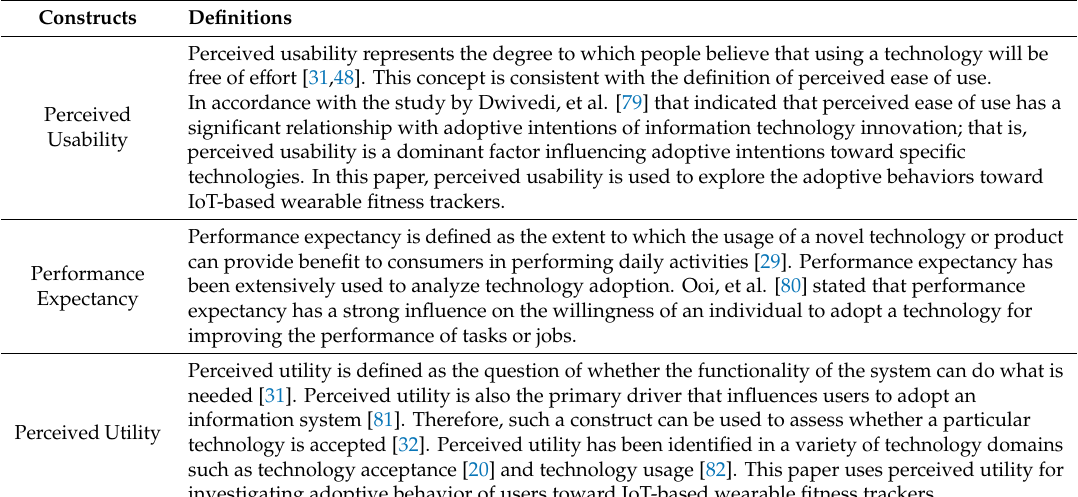
Table 1. Construct definitions of users’ adoption of IoT-based wearable fitness